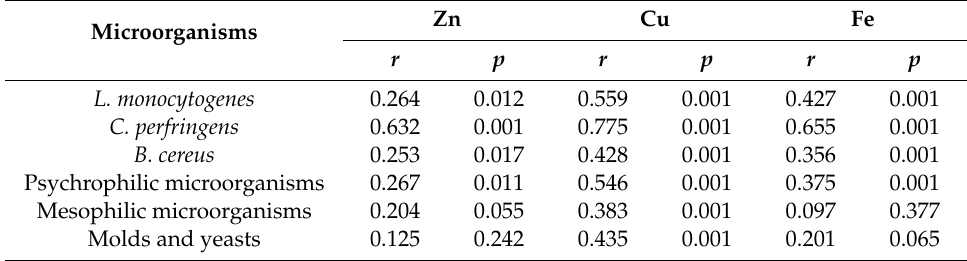
Table 4. Linear correlation coe ffi cients ( r ) and significance levels ( p ) between measured Zn, Cu, and Fe concentrations in the herbs and the microbial count values (CFU / g) for Listeria monocytogenes , Clostridium perfringens , Bacillus cereus , psychrophilic microorganisms, mesophilic microorganisms, and molds and yeasts in culture media previously infused with those